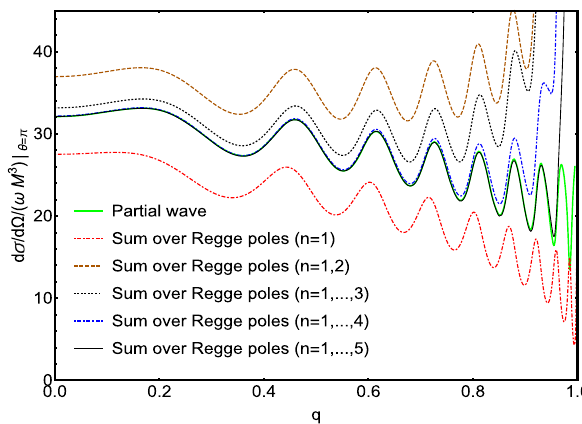
Fig. 13 Comparison of the amplitudes of the backscattered waves obtained by the partial wave method and the sum over Regge poles